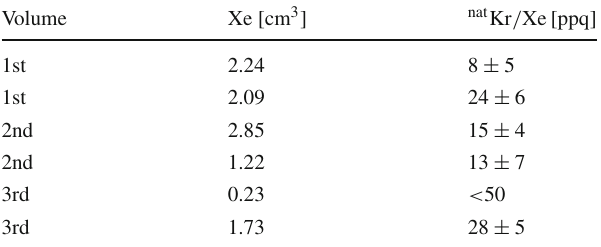
Table 1 Results from the concentration measurement of the purified liquid-out sample. Six measurements using the RGMS system were performed on the three volumes containing the liquid-out sample. The sample was drawn during the commissioning of the Phase-1 column